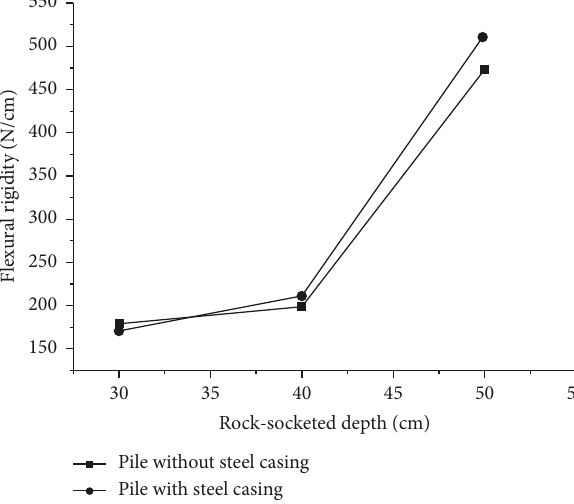
Figure 17: Comparison of the failure modes of the two kinds of rock-socketed